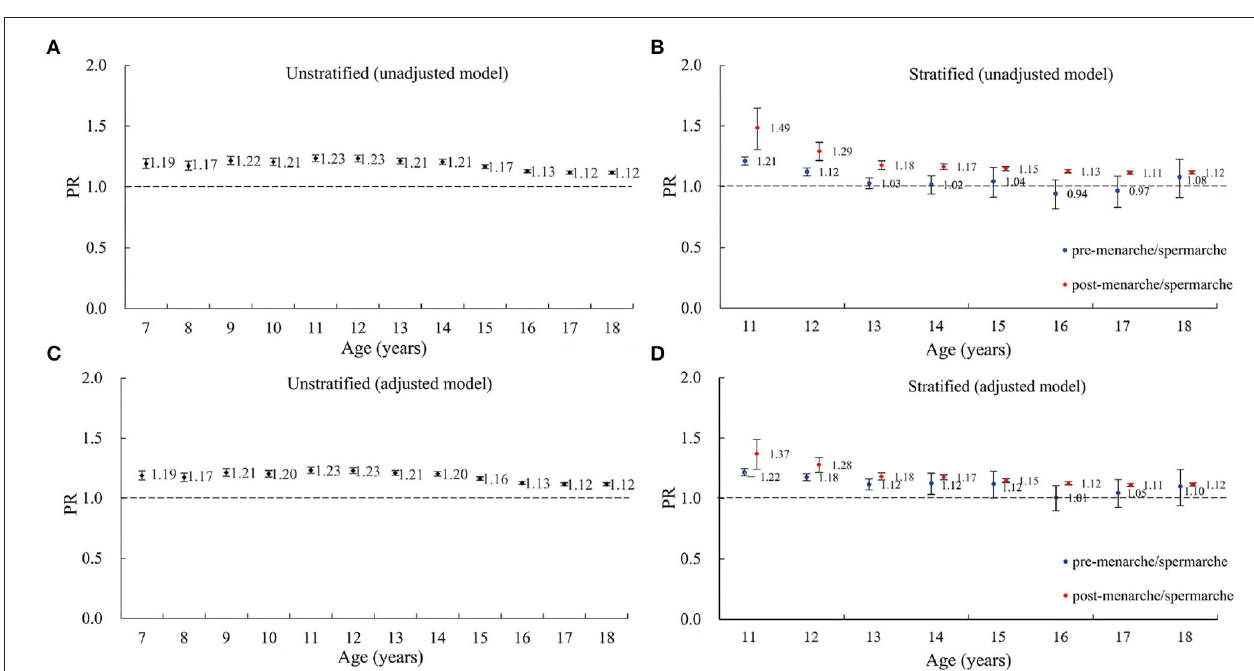
FIGURE 2 | Sex disparity of myopia prevalence among boys and girls aged 11–18 years in the 1995, 2000, 2005, 2010, and 2014 CNSSCH, stratified by age and menarche/spermarche status. P (Girls) and P (Boys) represent the prevalence of myopia in boys and girls, respectively. * represents the statistical significance of sex differences in myopia prevalence.